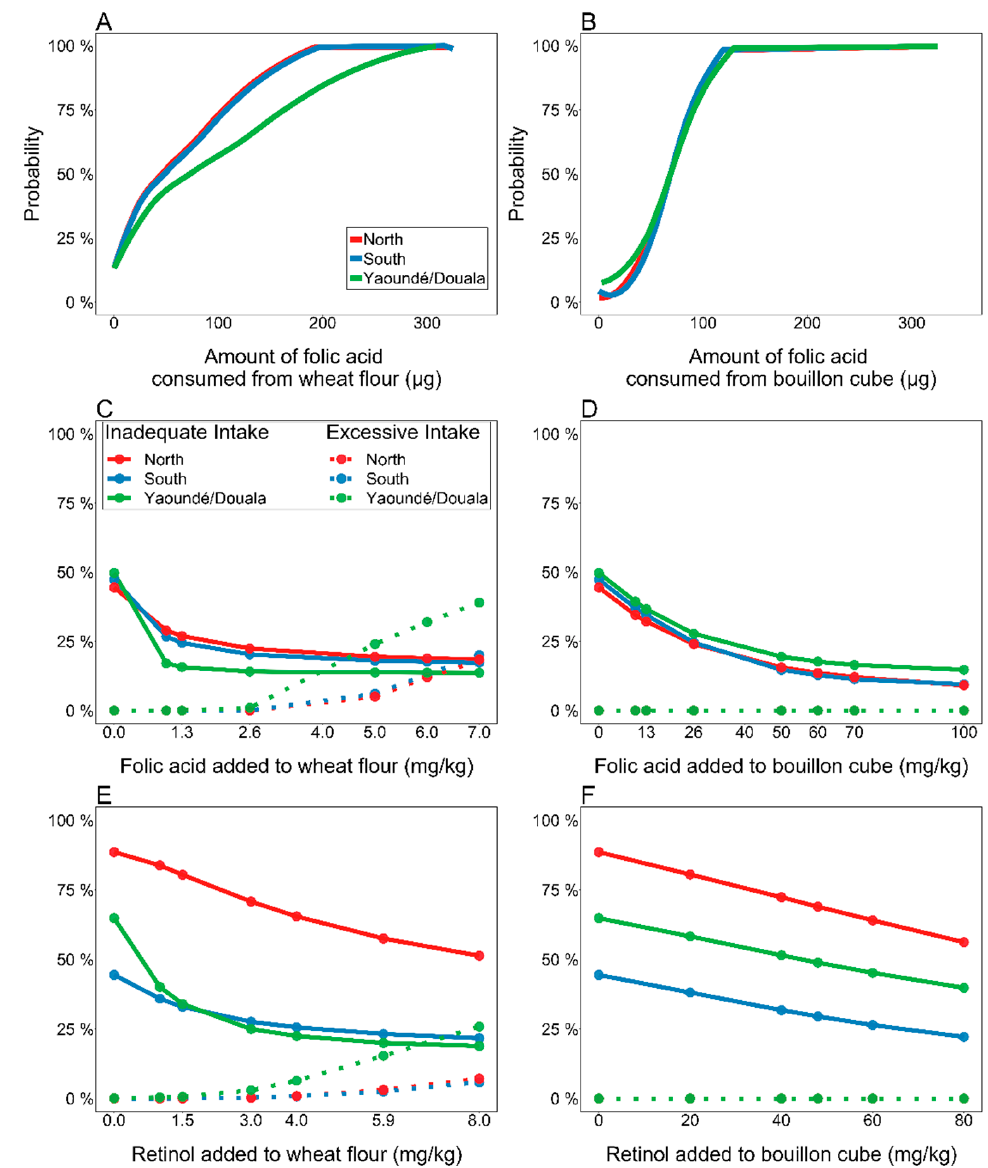
Figure 1. Distribution of folic acid consumption from fortified wheat flour or bouillon cube intake at equivalent fortification levels based on mean national intake, and relative effects of fortification of each vehicle on inadequate and excessive intakes among Cameroonian children 1–4 years of age. For Panels C–F, solid lines indicate prevalence of inadequate intakes, and dotted lines indicate prevalence of intakes above the UL. (A) Cumulative probability distribution of folic acid intake from wheat flour, at 2.6 mg/kg (designed to provide 70 µg/day based on average national intake of 27.0 g/day). (B) Cumulative probability distribution of folic acid intake from bouillon cube, at 70 mg/kg (designed to provide 70 µg/day based on average national intake of 1.0 g/day). (C) Prevalence of inadequate and excessive folate intakes at different levels of fortification of wheat flour. (D) Prevalence of inadequate and excessive folate intakes at different levels of fortification of bouillon cube. (E) Prevalence of inadequate and excessive vitamin A intakes at different levels of fortification of wheat flour. (F) Prevalence of inadequate and excessive vitamin A intakes at different levels of fortification of bouillon cube. Reproduced in accordance with a CC-BY Creative Commons Attribu- tion license (citation: Reina Engle-Stone, Stephen A. Vosti, Hanqi Luo, Justin Kagin, Ann Tarini, Katherine P. Adams, Caitlin French, Kenneth H. Brown. Weighing the risks of high intakes of se- lected micronutrients compared with the risks of deficiencies. Annals of the New York Academy of Sciences. 2019; 1446(1): 81-101. doi:10.1111/nyas.14128).